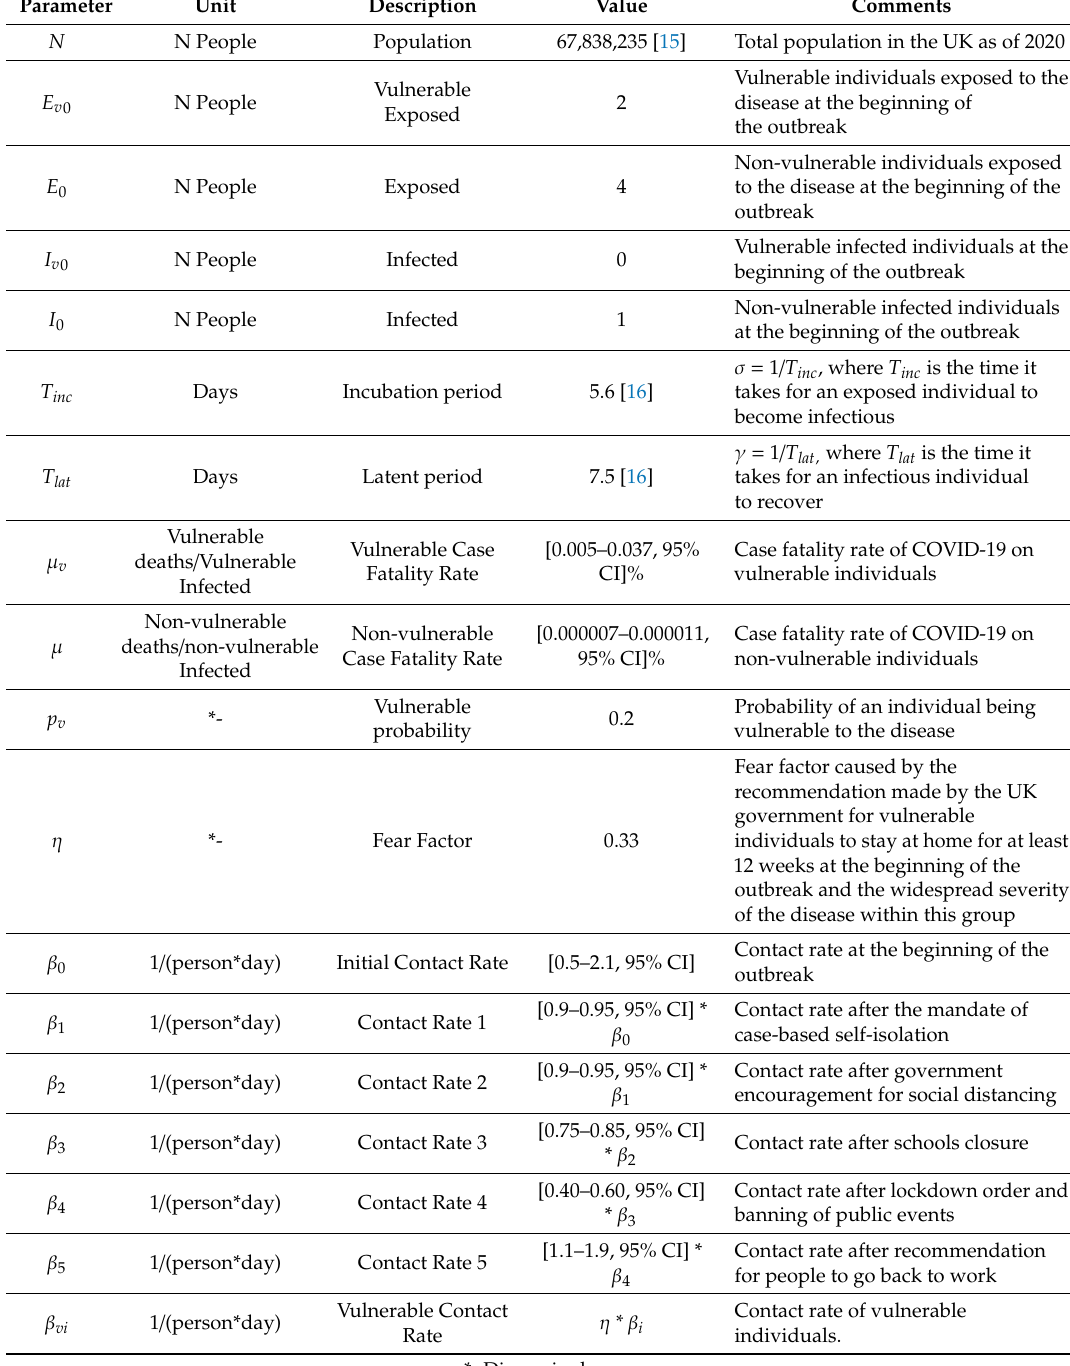
Table 1. Description of the SEIR-v model